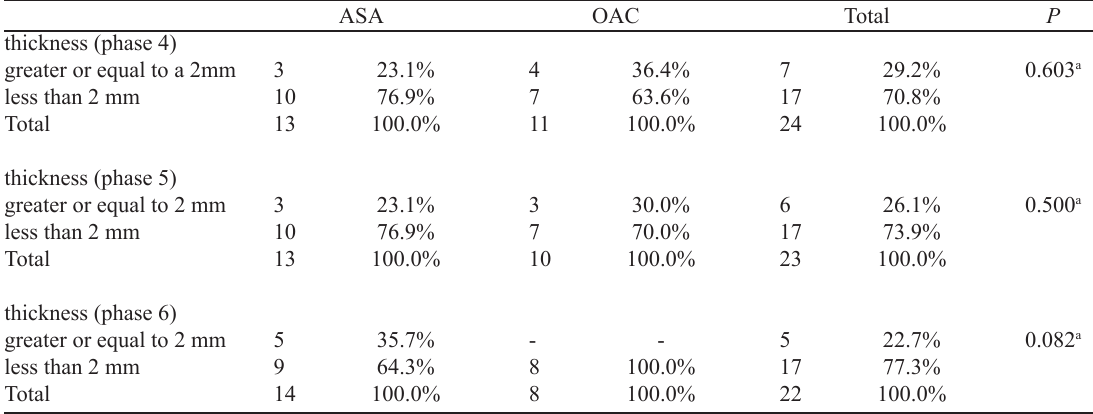
Table 5. Distribution of the thickness of the deposited material of patients in ASA and OAC groups in phases 4, 5 and